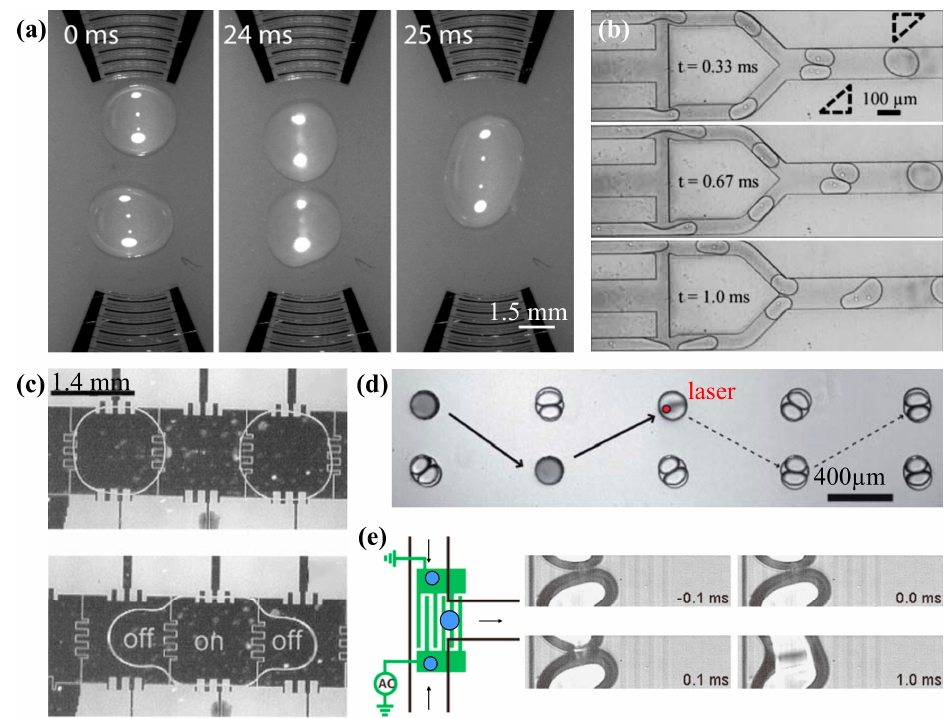
Figure 7. Overview of droplet merging techniques. ( a ) Merging two microliter sized droplets using two SAWs focused by a tapered electrode geometry. Adapted from [71] with permission of The Royal Society of Chemistry; ( b ) Electrocoalescence of two cell-containing, surfactant-covered droplets, while travelling through the electric field created by two electrodes as indicated by the dashed triangles. Coalescence frequency is > 1 kHz. Adapted with permission from [107]. Copyright 2014 by John Wiley & Sons Inc., Hoboken, NJ, USA; ( c ) EWOD electrode geometry used to bring two droplets together after splitting. Copyright 2003 IEEE. Reprinted, with permission, from [13]; ( d ) After trapping two surfactant-covered droplets with different content in surface energy wells, they are merged using a laser spot focused at the droplet-droplet interface. Adapted from [5] with permission of The Royal Society of Chemistry; ( e ) Similar to electrocoalescence, interdigitated electrodes below a microchannel will merge two surfactant-covered droplets within milliseconds. Adapted with permission from [93]. Copyright 2011, AIP Publishing